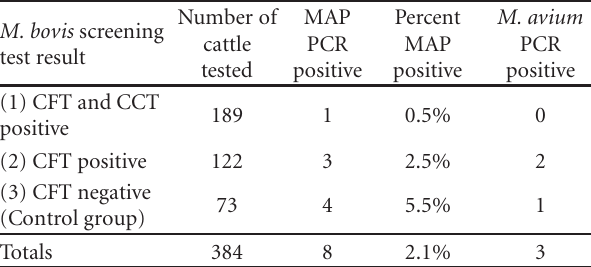
Table 1: Summary of results of various screening tests for bovine tuberculosis and for results of PCR